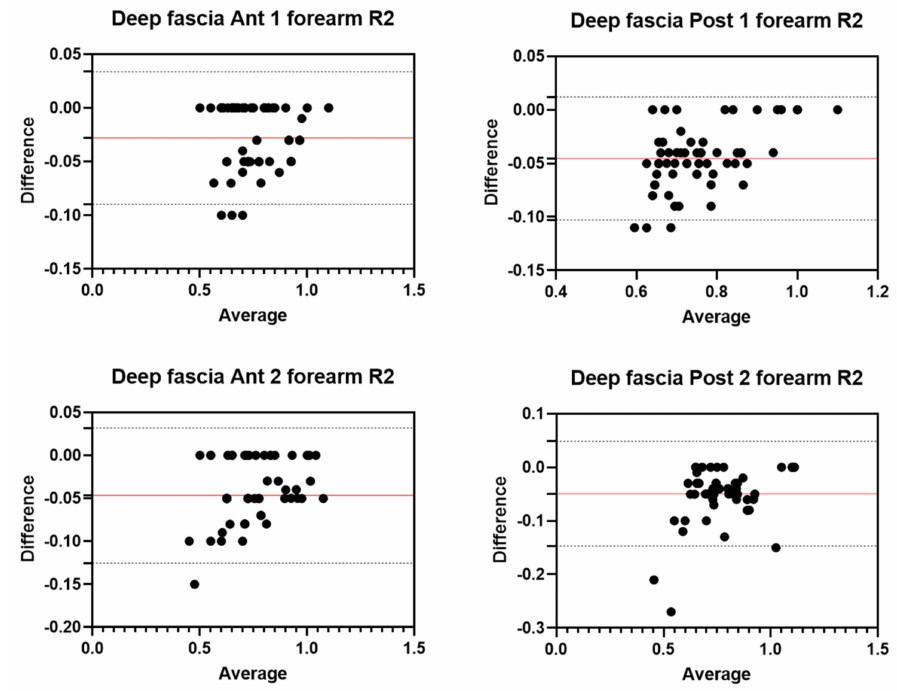
Figure 6. Bland–Altman plot comparing two sessions of Rater 2 (R2) measuring the US thickness of the deep fascia of the forearm for the different/levels. Red line = bias or mean difference; dashed lines: 95% limits of agreement (LoAs).